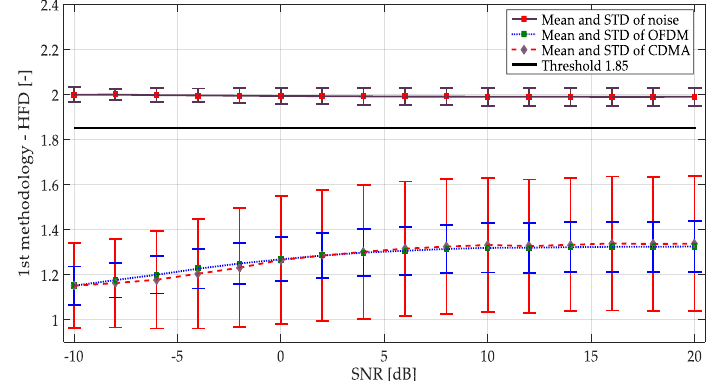
Figure 14. Mean and standard deviation (STD) for noise and simulated symbols (OFDM and NRZ-CDMA) applying the first methodology.